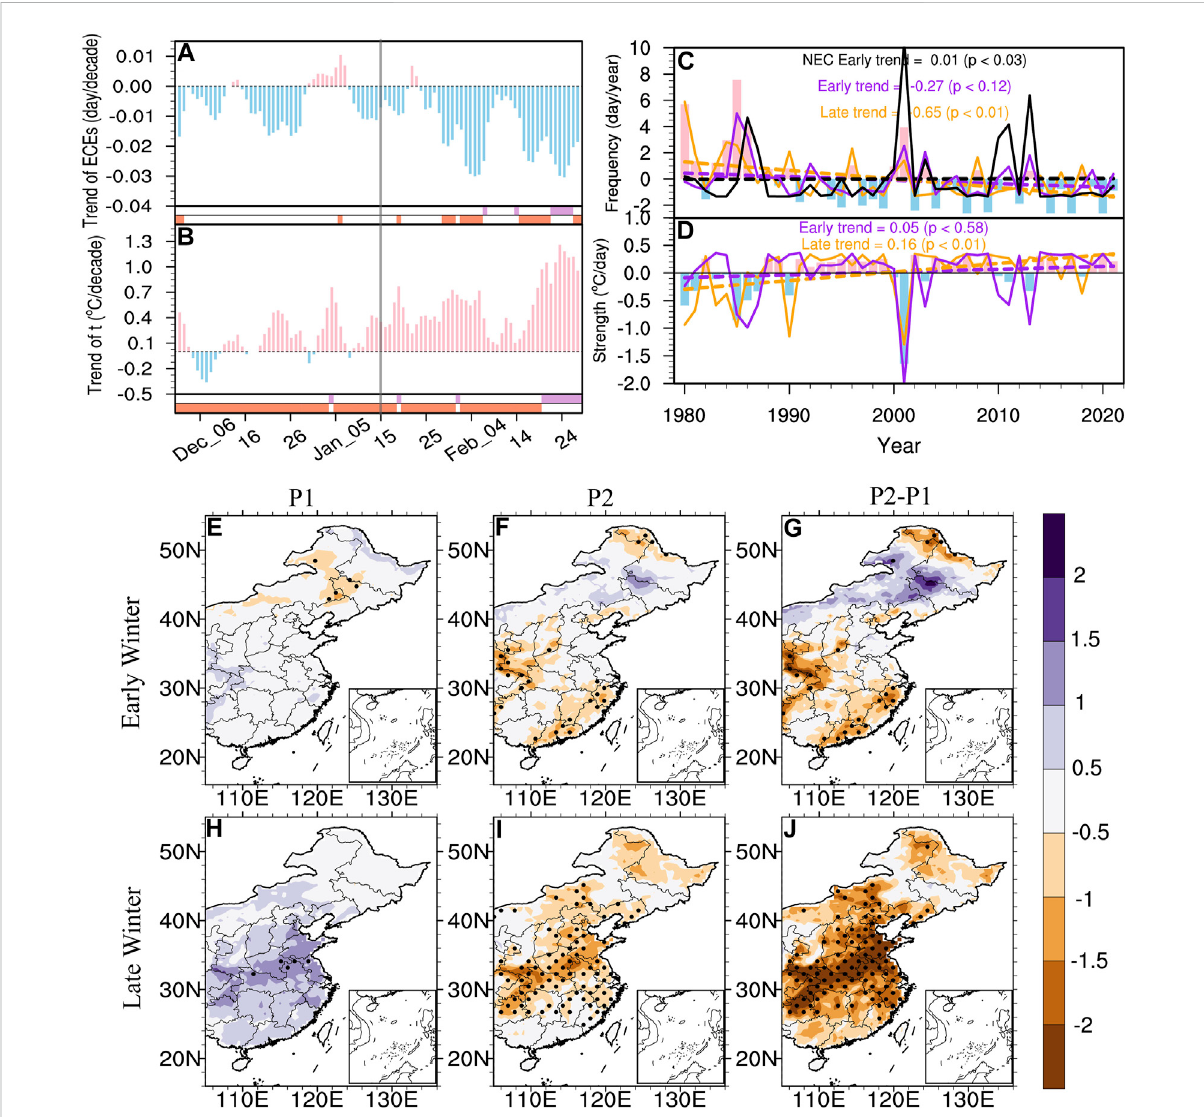
FIGURE 1 Trend in (A) the number of days with ECEs (units: days/decade) and (B) the minimum 2 m temperature (units: ° C/decade) during ECE days over eastern China in winter from 1980 to 2021. The lower column diagram represents the signi fi cant test, where purple represents p < 0.05, orange p < 0.1 and white p ≥ 0.1. Time series of (C) ECE days (units: day/year) and (D) intensity (units: ° C/day) during ECE days over eastern China in winter from 1980 to 2021, where the purple solid line represents early winter, the orange solid line represents late winter, the histogram represents the whole winter,and thepurple andorangedashedlines are thelinear trendsofearly winterand latewinter, respectively. (C) The black solidline isearly winter in northeast China (NEC, 42 – 55 ° N, 110 – 125 ° E) and the black dashed line is the linear trend in northeast China. (E – G) Anomalous fi elds of the number of days with ECEs (units: day/year) during the P1 (1980 – 2000), P2 (2001 – 2021) and (P2 − P1) stages over eastern China in early winter, respectively. (H – J) Anomalous fi eldsoftheP1,P2and(P2 − P1)stagesovereasternChinainlatewinter,respectively.Theblackdotsare p < 0.1(units: day/year). Anomalies were computed relative to the 30-years climatology from 1981 to